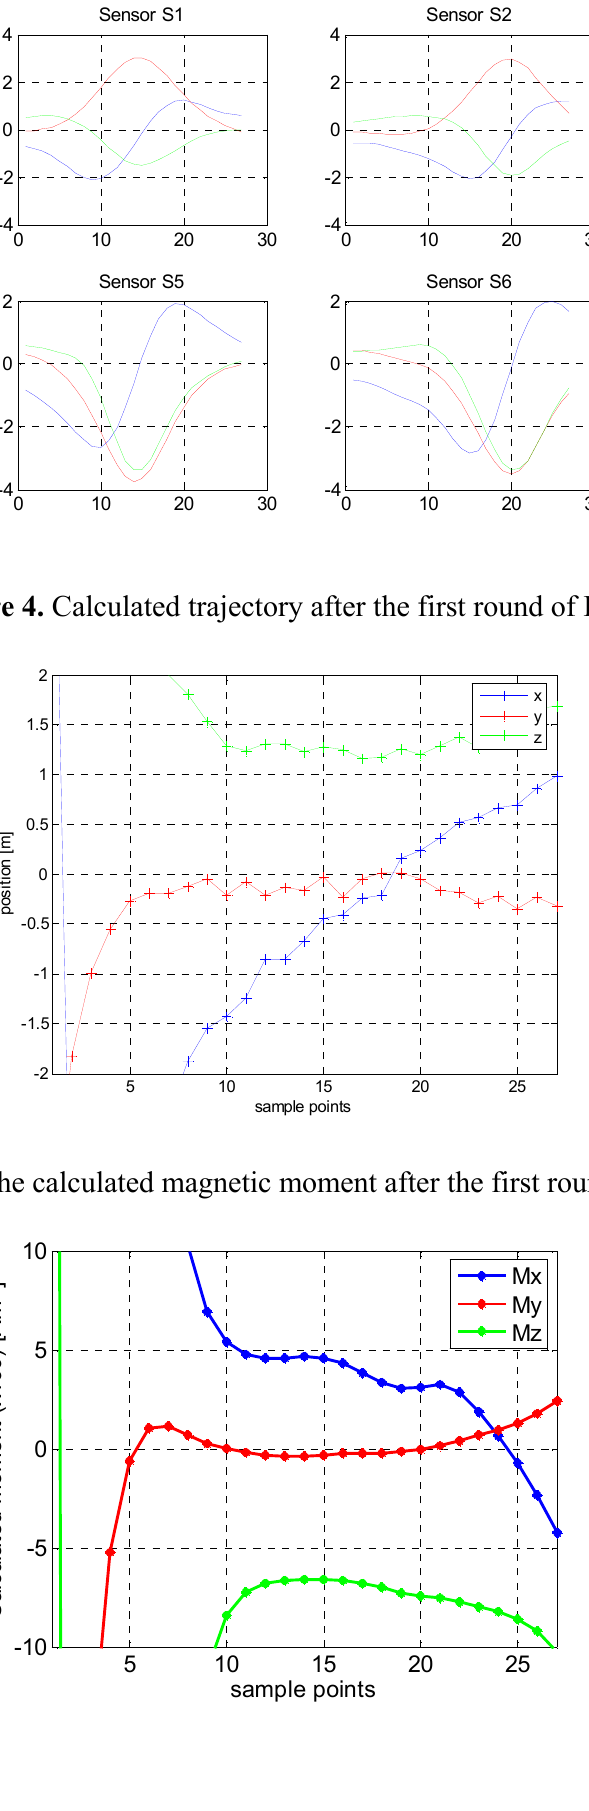
Figure 3. Isolated relevant data shown in Figure 2.